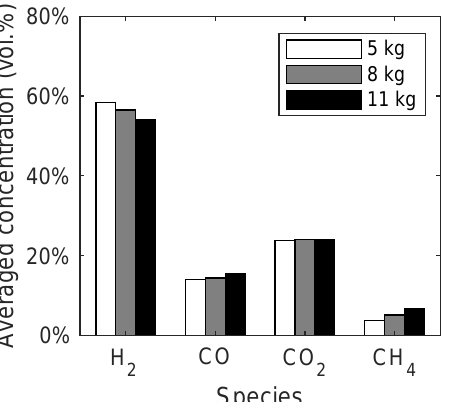
Figure 5. Syngas composition depending on the bed mass of quartz sand in the spouted